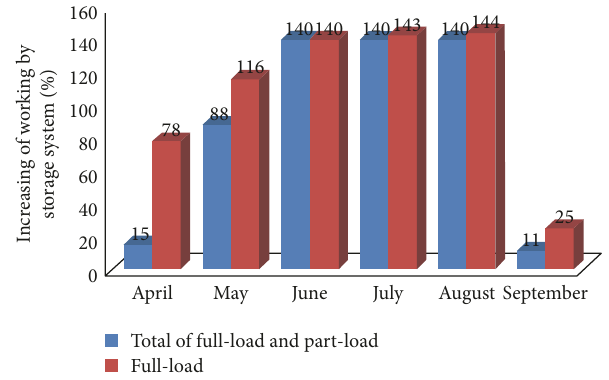
Figure 19: Percentage of the operating hour increasing in the solar fi eld by the storage